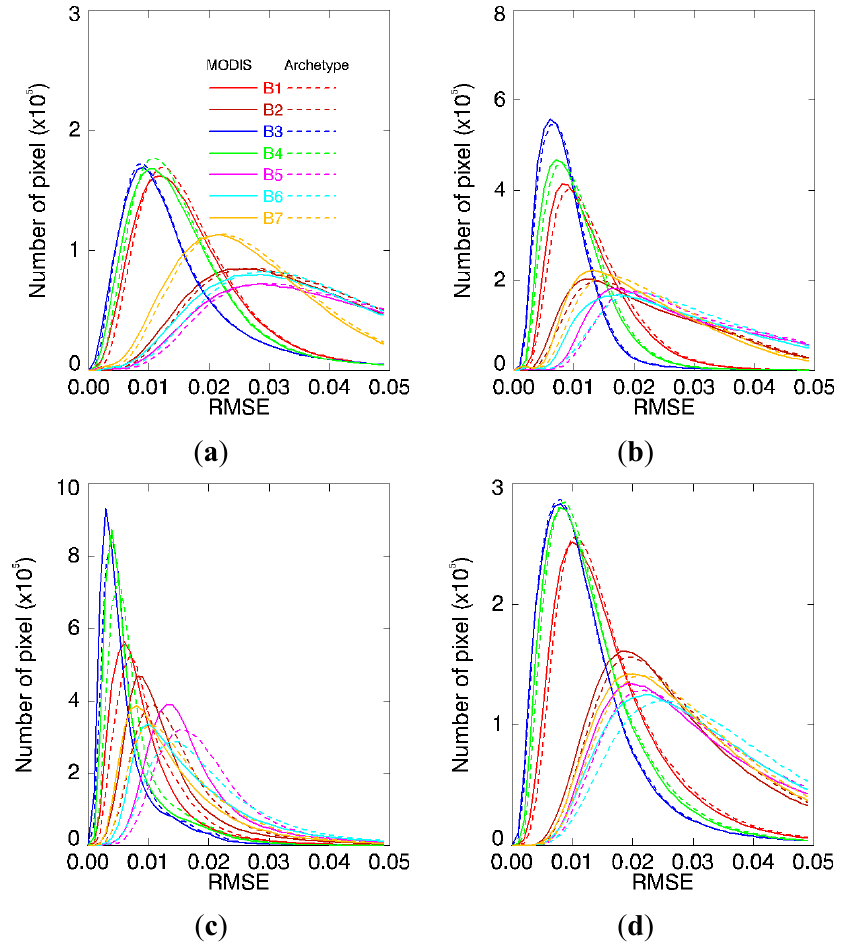
Figure 5. Histograms of RMSEs of the MODIS BRDF product (solid lines) and BRDF archetypes (dashed line) in seven MODIS bands (B1-B7) for 2008, ( a ) day 65; ( b ) day 129; ( c ) day 249; and ( d ) day 329 for tile